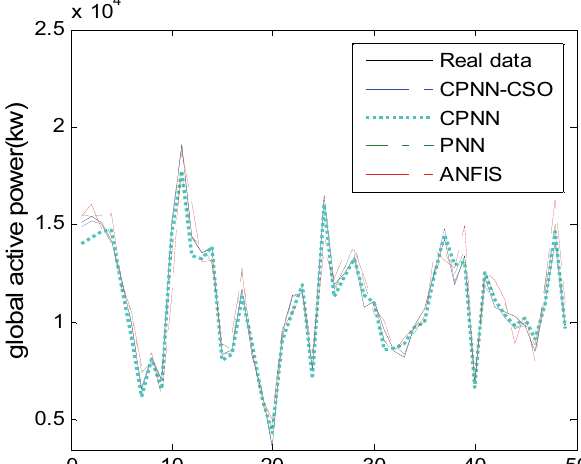
Fig.8. Prediction result comparison with four methods